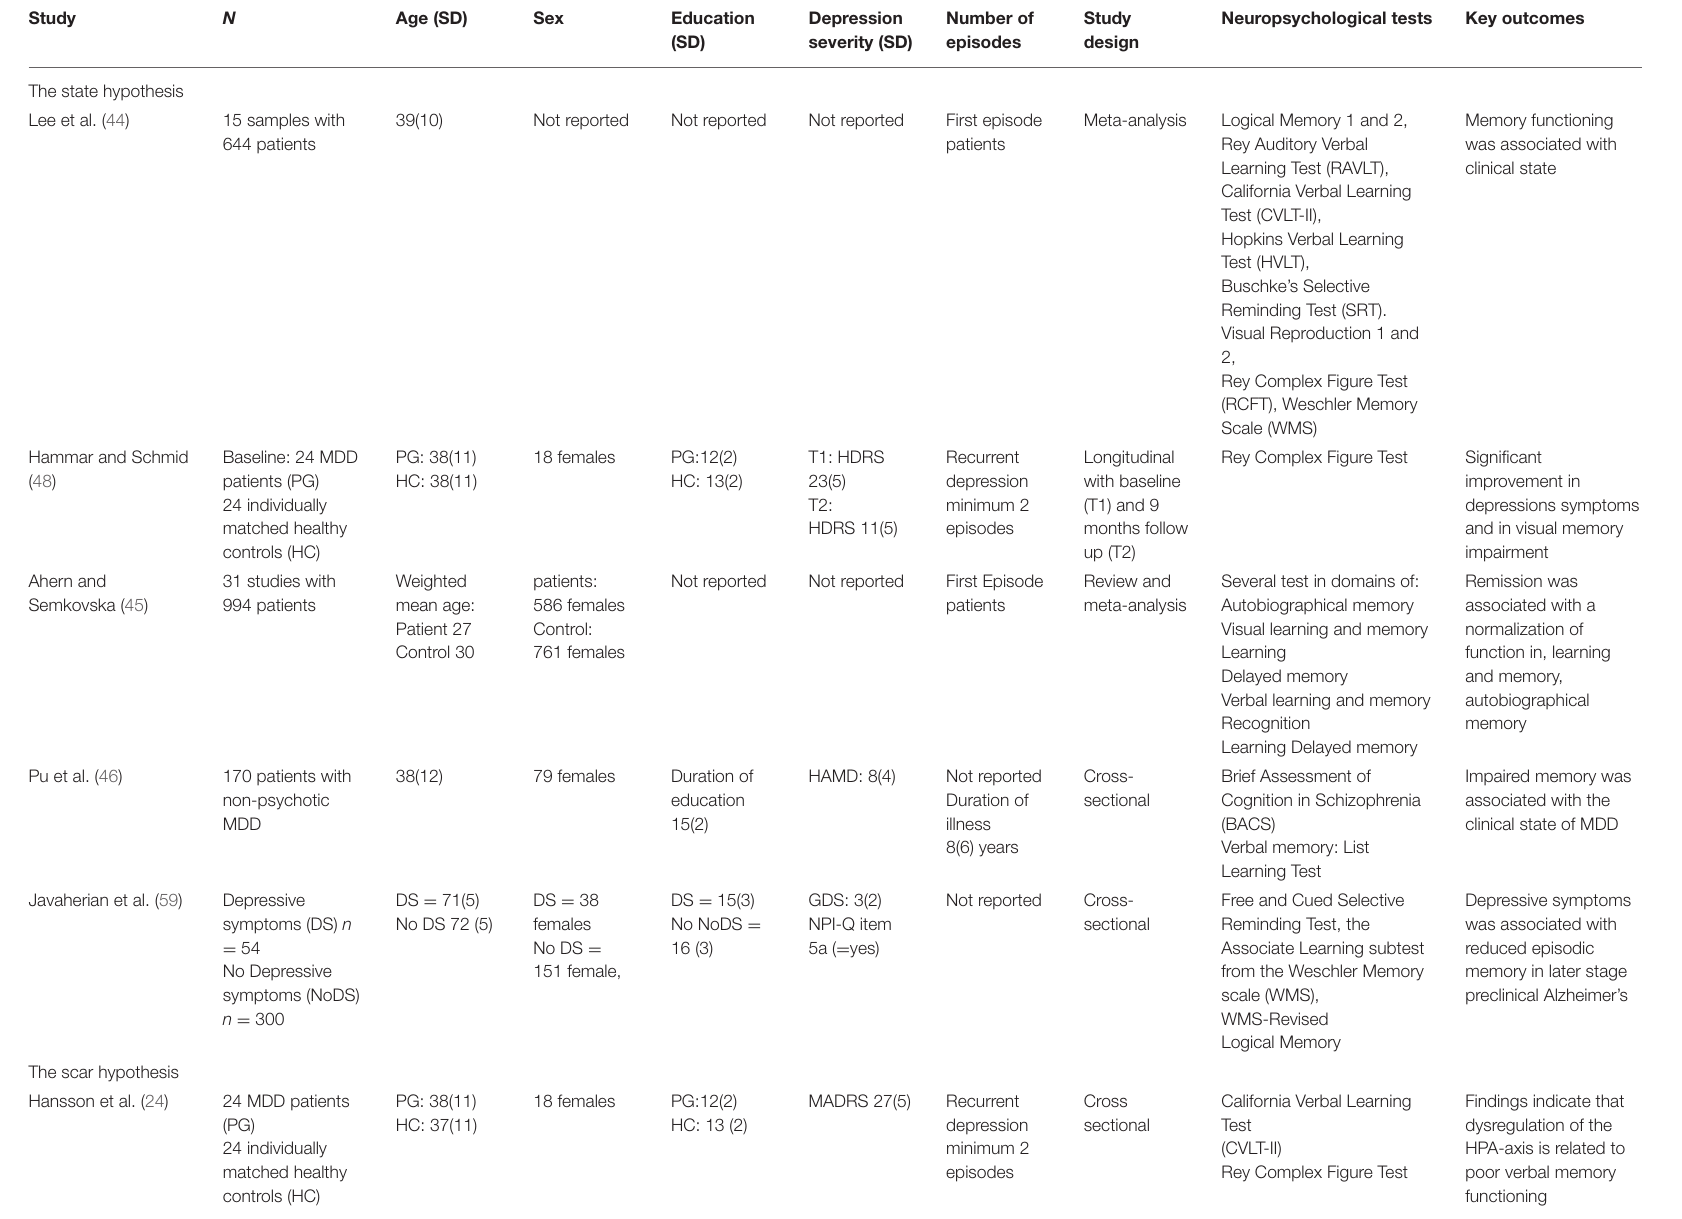
TABLE 1 | Findings within the domain of memory regarding origin of